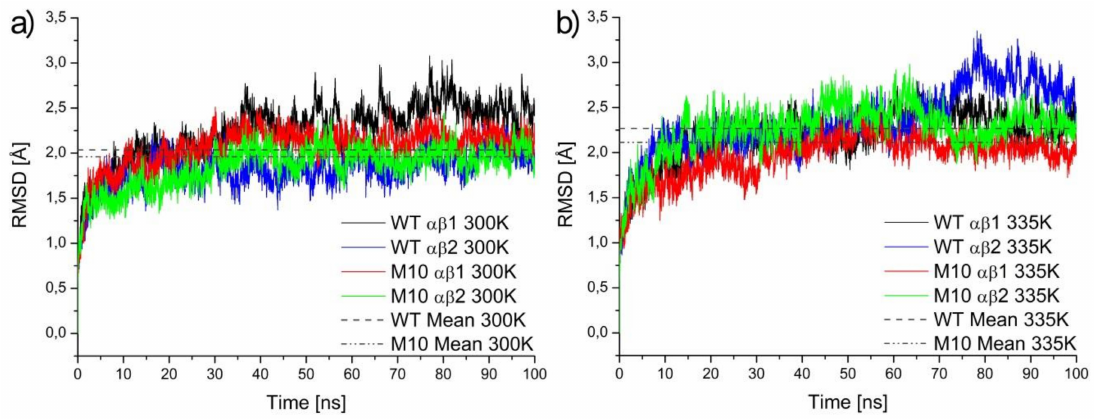
Figure 2. RMSD values for simulation of WT Pt NHase and its M10 mutant in 300 K ( a ) and 335 K ( b ).